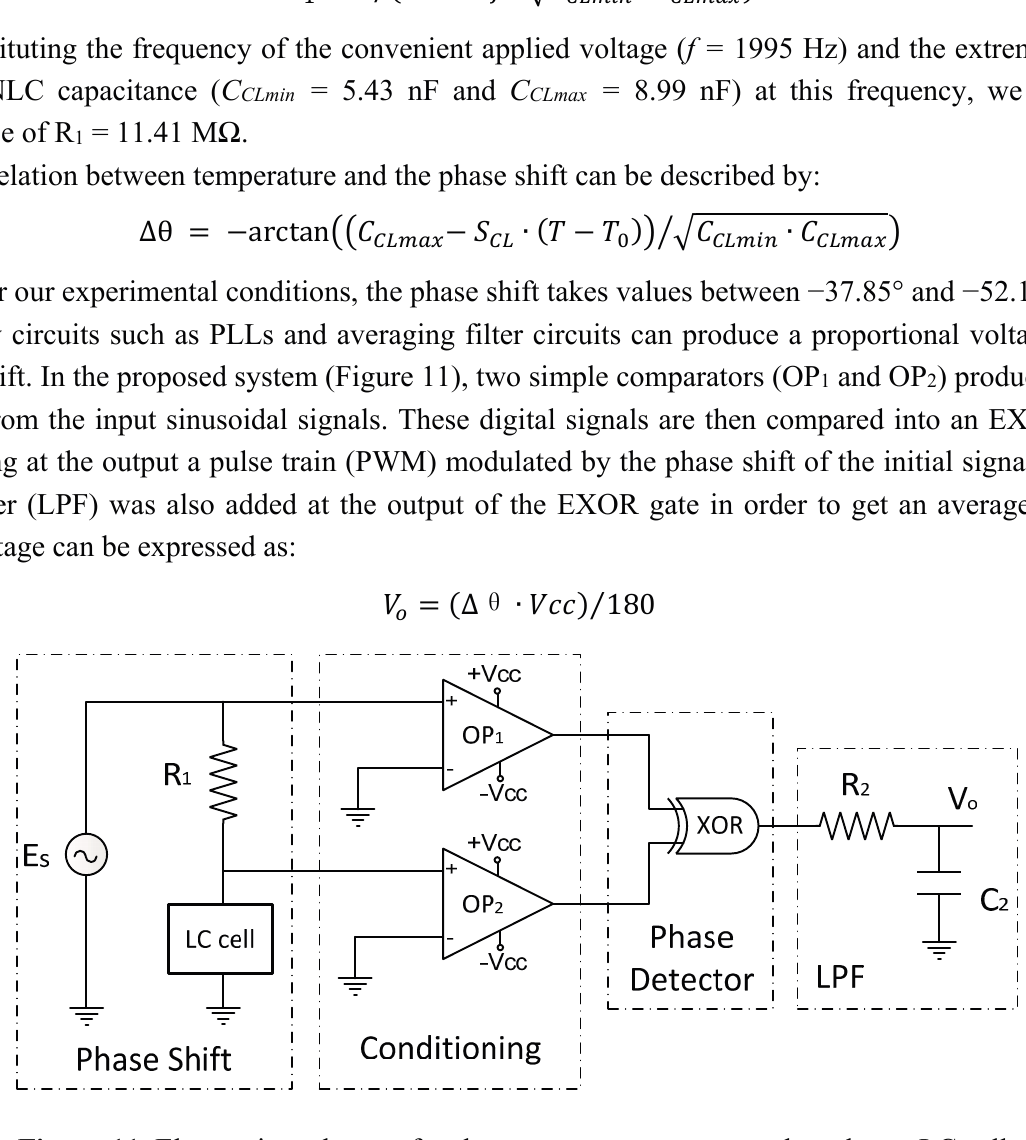
Figure 11. Electronics scheme of a phase-measurement system based on a LC